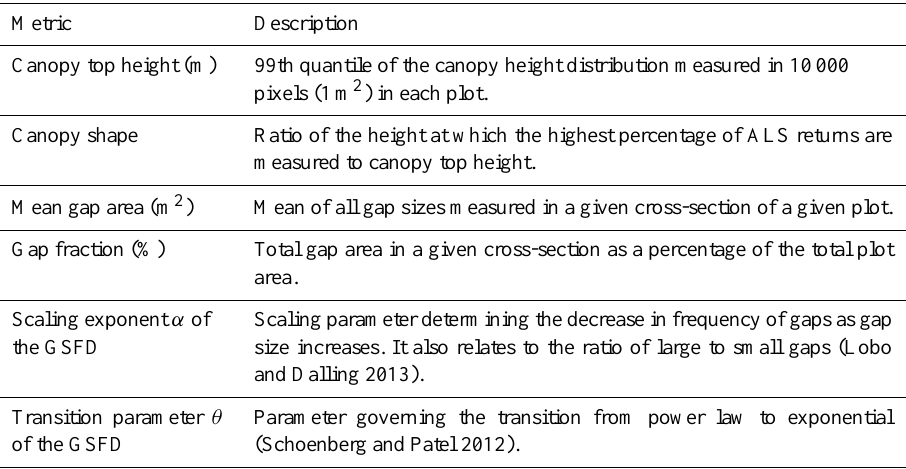
Table 1. List and description of canopy structure metrics used in this study. Metric Description Canopy top height (m) 99th quantile of the canopy height distribution measured in 10000 pixels (1m 2 ) in each plot. Canopy shape Ratio of the height at which the highest percentage of ALS returns are measured to canopy top height. Mean gap area (m 2 ) Mean of all gap sizes measured in a given cross-section of a given plot. Gap fraction (%) Total gap area in a given cross-section as a percentage of the total plot area. Scaling exponent α of Scaling parameter determining the decrease in frequency of gaps as gap the GSFD size increases. It also relates to the ratio of large to small gaps (Lobo and Dalling 2013). Transition parameter θ Parameter governing the transition from power law to exponential of the GSFD (Schoenberg and Patel